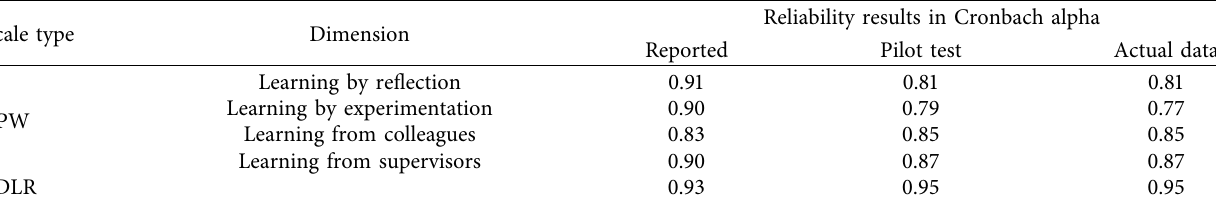
Table 2: Reliability of the scales used to collect research